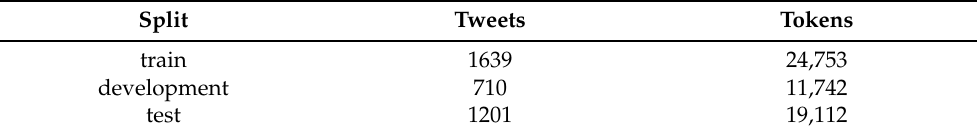
Table 3. Statistics of Tweebank v2.